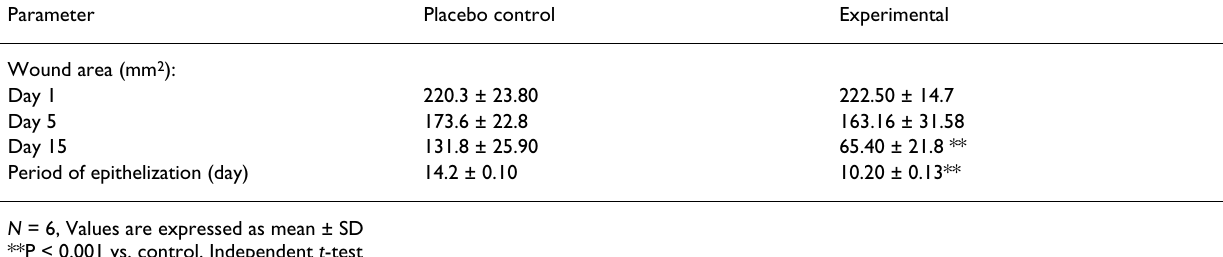
Table 3: Wound healing effect of C. roseus in Dead space wound model Parameter Placebo control